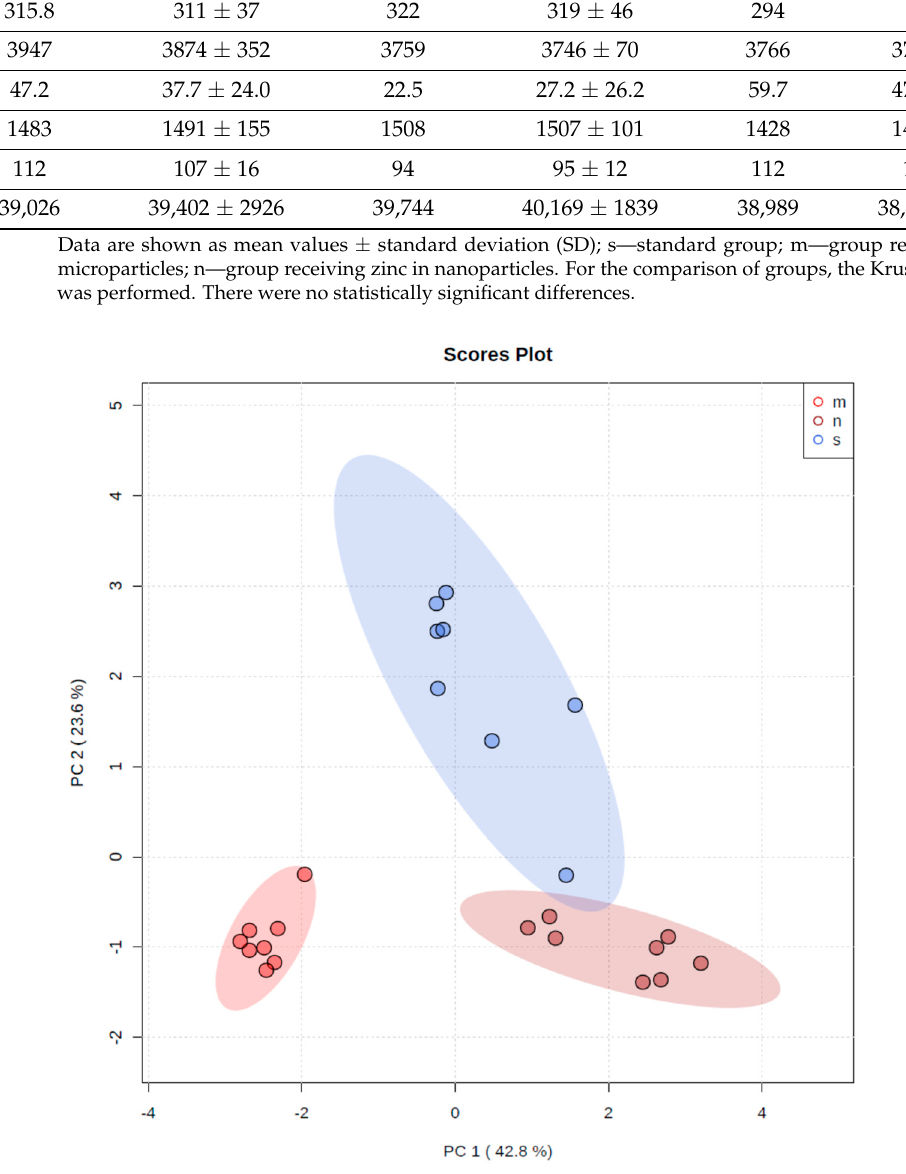
Figure 2. The principal component analysis performed on three groups: s-control, standard diet (blue boxplot); n-nanozinc supplementation diet (dark red boxplot); m-microzinc supplementation diet (red boxplot).